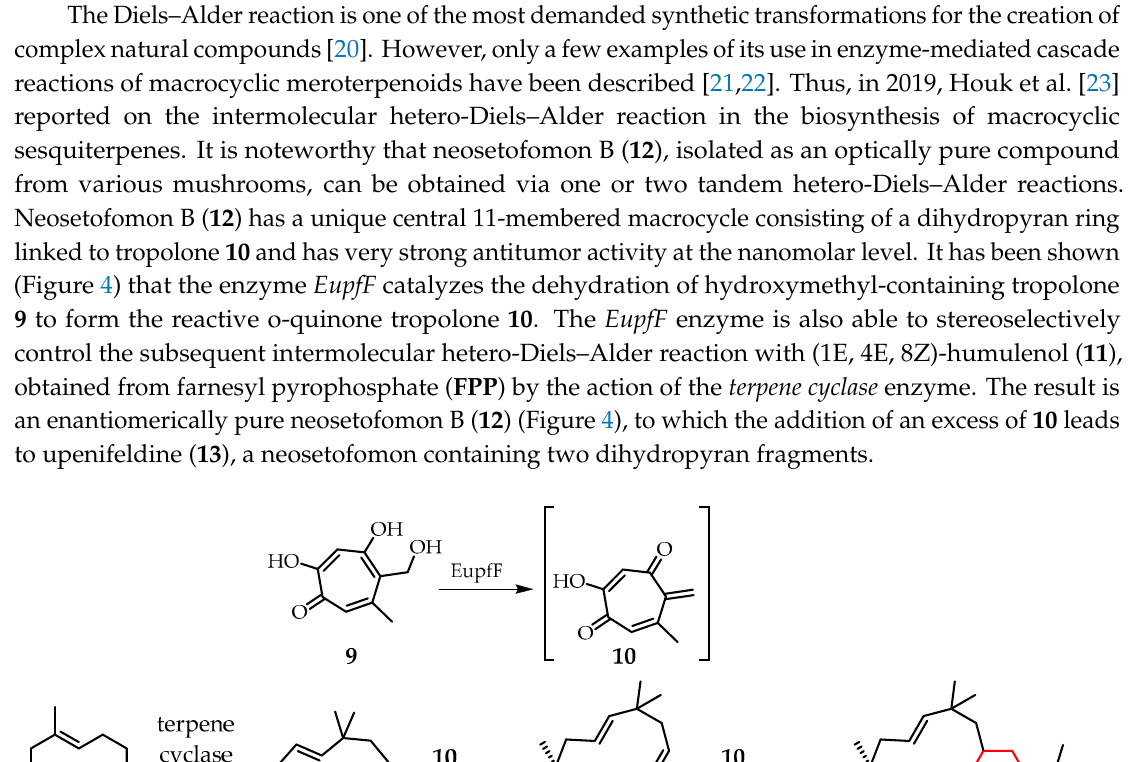
Figure 4. Biosynthetic way for the production of neosetofomon B ( 12 ) and upenifeldin ( 13 ).